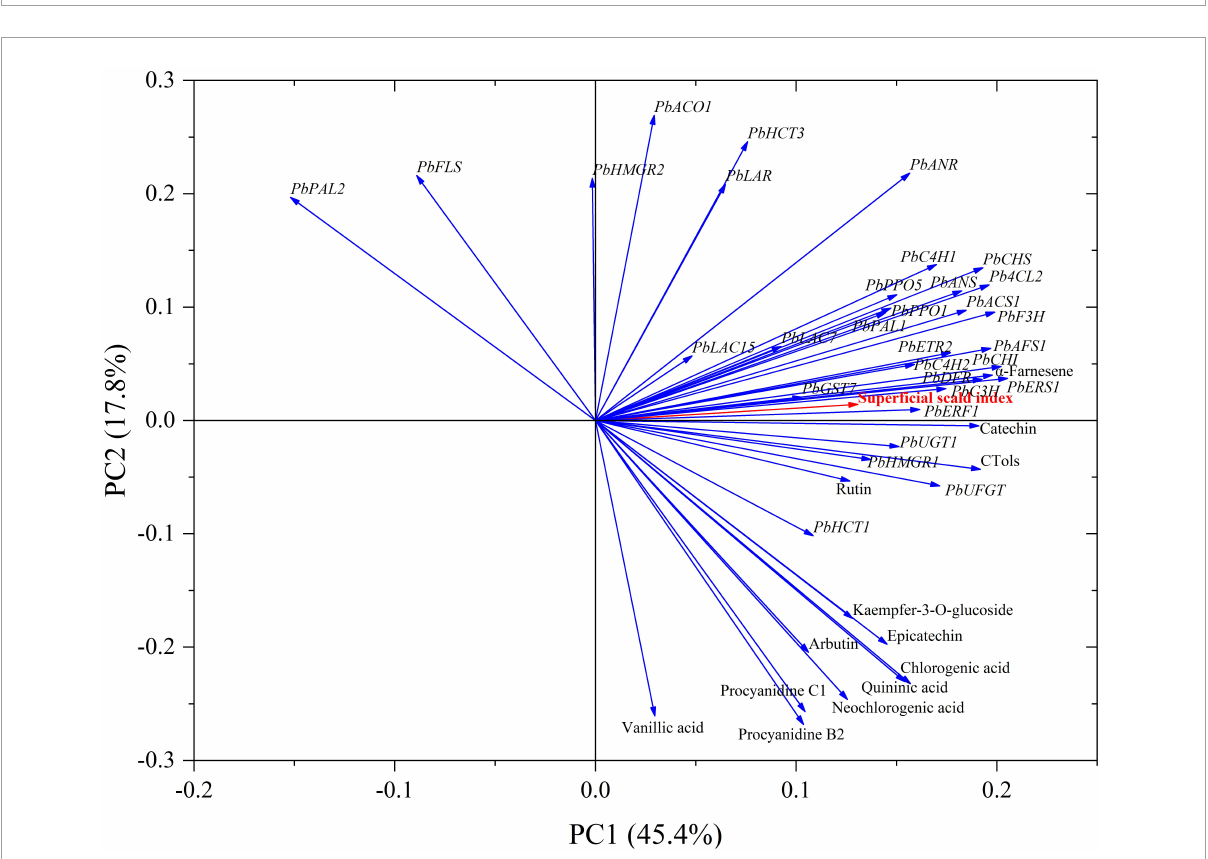
FIGURE7 Loading plot of principal component analysis (PCA) of scald index, phenolics contents, and the related genes expression levels in the peels of the control group and 1-MCP-treated “Yali” pears. Arrows indicated the different variables.